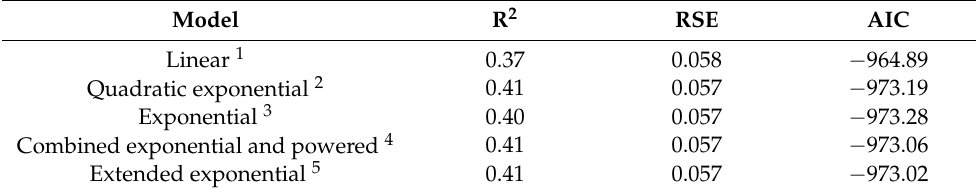
R 2 : determination coefficient; RSE: root mean square error; AIC: Akaike Information Criterion. Exponential model outputs at hourly and daily resolutions are represented in Figures S4 and 7, respectively. Based on the estimations, bare soil in Karcag, Hungary, emitted 483 ± 21